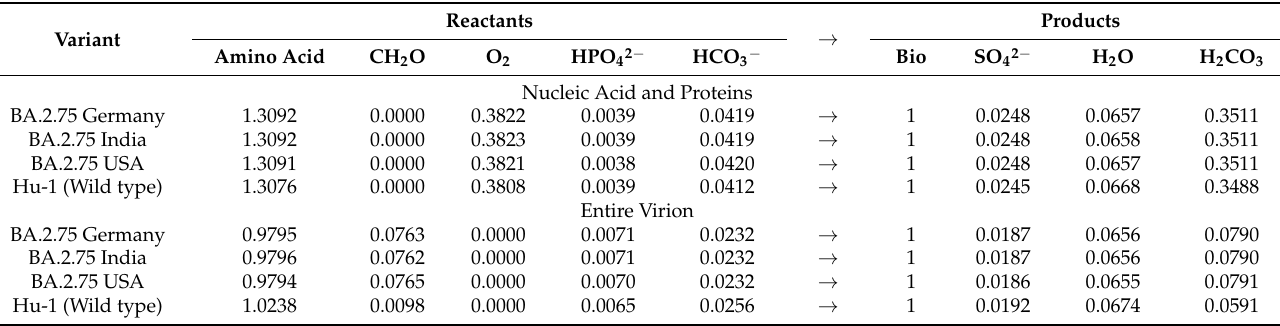
Table 6. Stoichiometric coefficients for the biosynthesis reactions of the SARS-CoV-2 nucleic acid and proteins and entire virions. Nucleic acids and proteins represent the viral RNA together with the nucleoprotein, membrane proteins, and spike protein. On the other hand, the entire virion includes the nucleic acid, proteins, and envelope lipids. (Bio) denotes the empirical formula of live matter (from Table